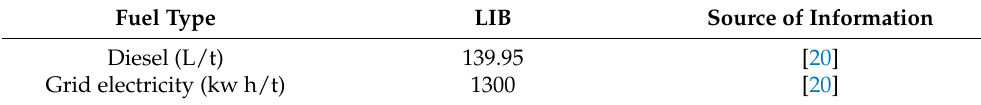
Table 5. The energy consumption of the recovery utilization process.